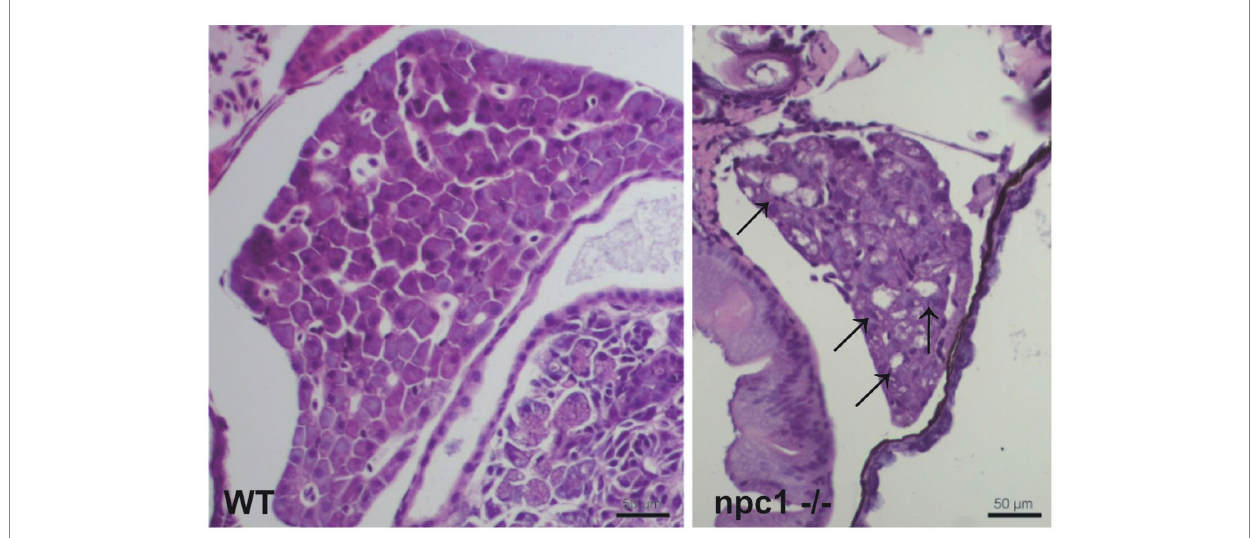
FIGURE 4 npc1 − / − larvae of 3 wpf have moderate to severe vacuolation and ballooning of hepatocytes (indicated with arrows). Scale bars: 50 μ m.